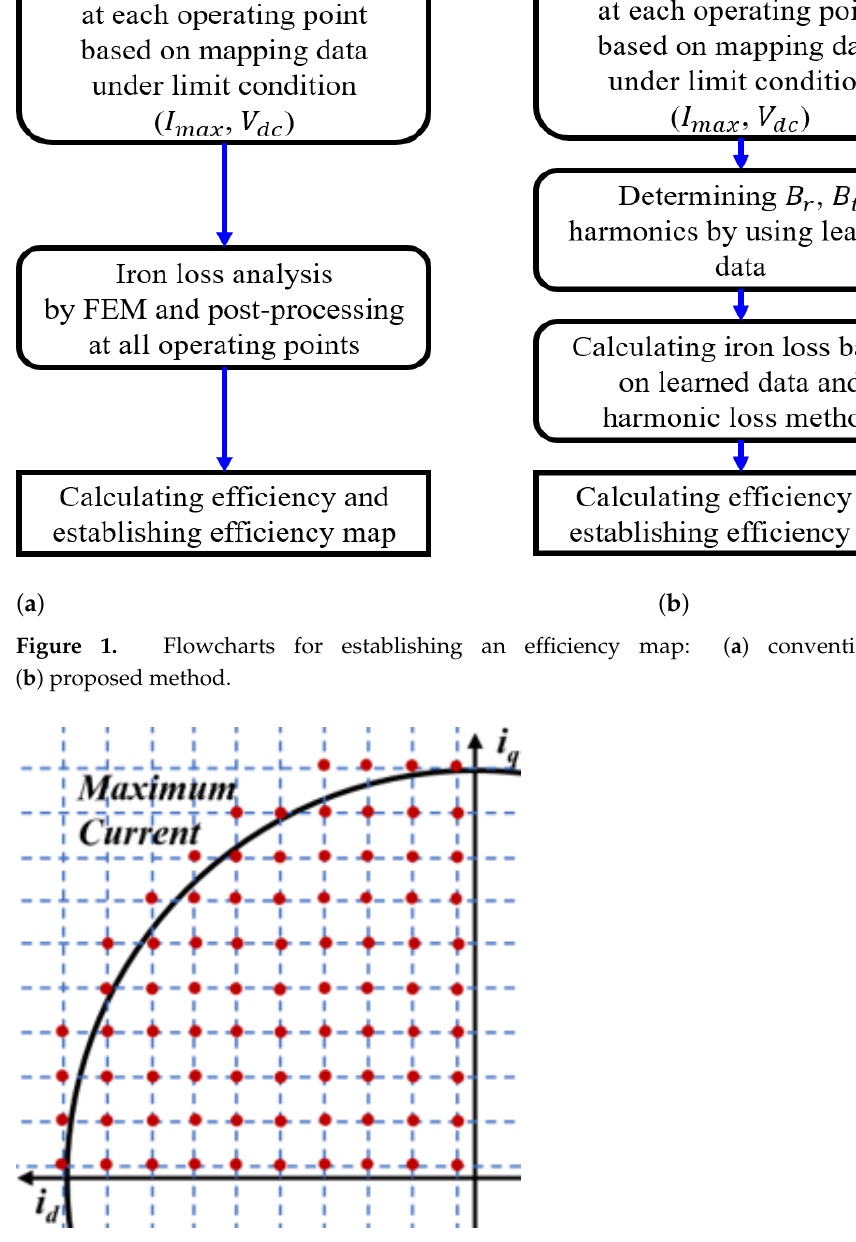
Figure 2. Analyzed points for the data map considering the maximum